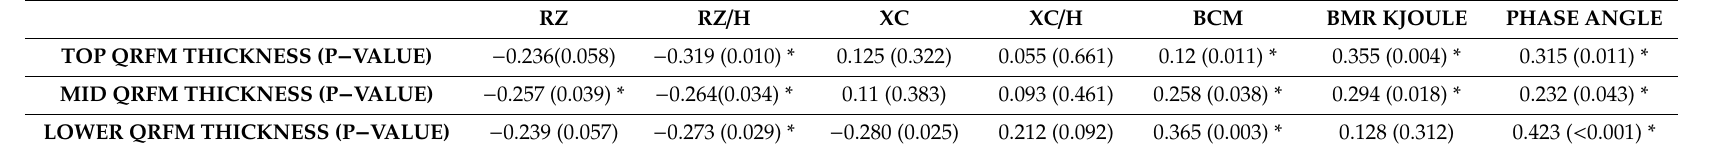
Table 4. Correlation between quadriceps rectus femoris thickness and BIVA parameters in hemodialysis patients.